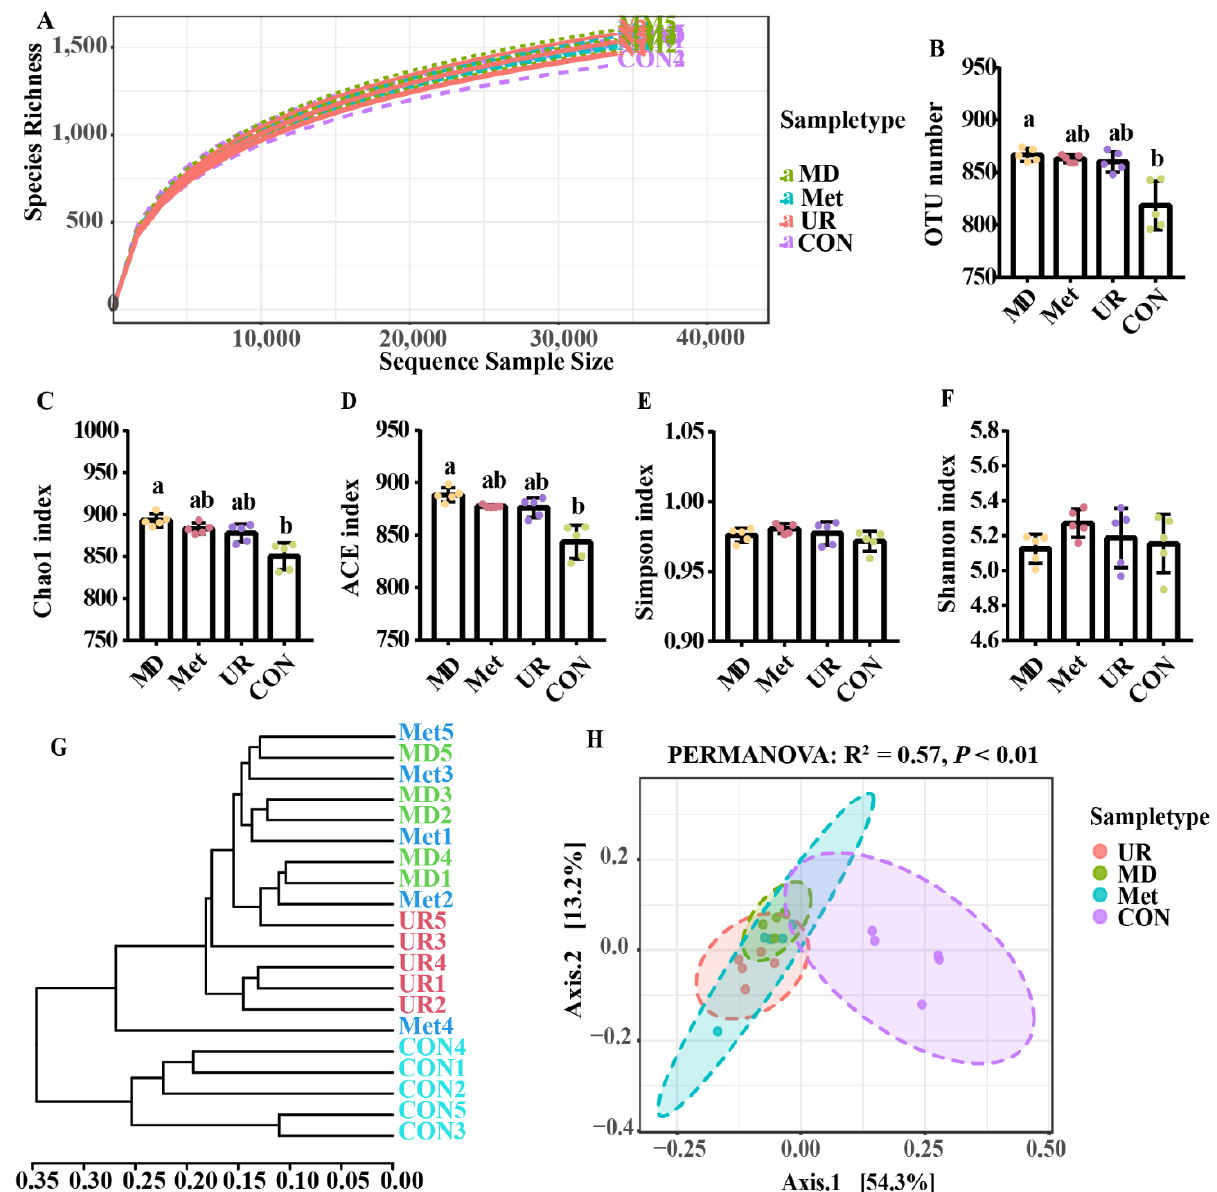
Figure 4. Rarefaction curves ( A ), OTU number ( B ), α diversity ( C – F ), dendrogram analysis ( G ), and β diversity ( H ) in response to the microbiota with urea, methionine or methionine dipeptide in vitro, after 48 h fermentation. CON = no additive, UR = urea addition, Met = methionine addition, and MD = methionine dipeptide addition. All analyses were based on the OTU level. A principal coordinate analysis plot based on the Bray–Curtis distances was conducted. p -value obtained using non-parametric multivariate of variance (PERMANOVA) based on Bray–Curtis distances ( H ). Means with different letters are significantly different ( p < 0.05). Vertical bars denote standard deviation (SD); n = 5 per treatment per time.